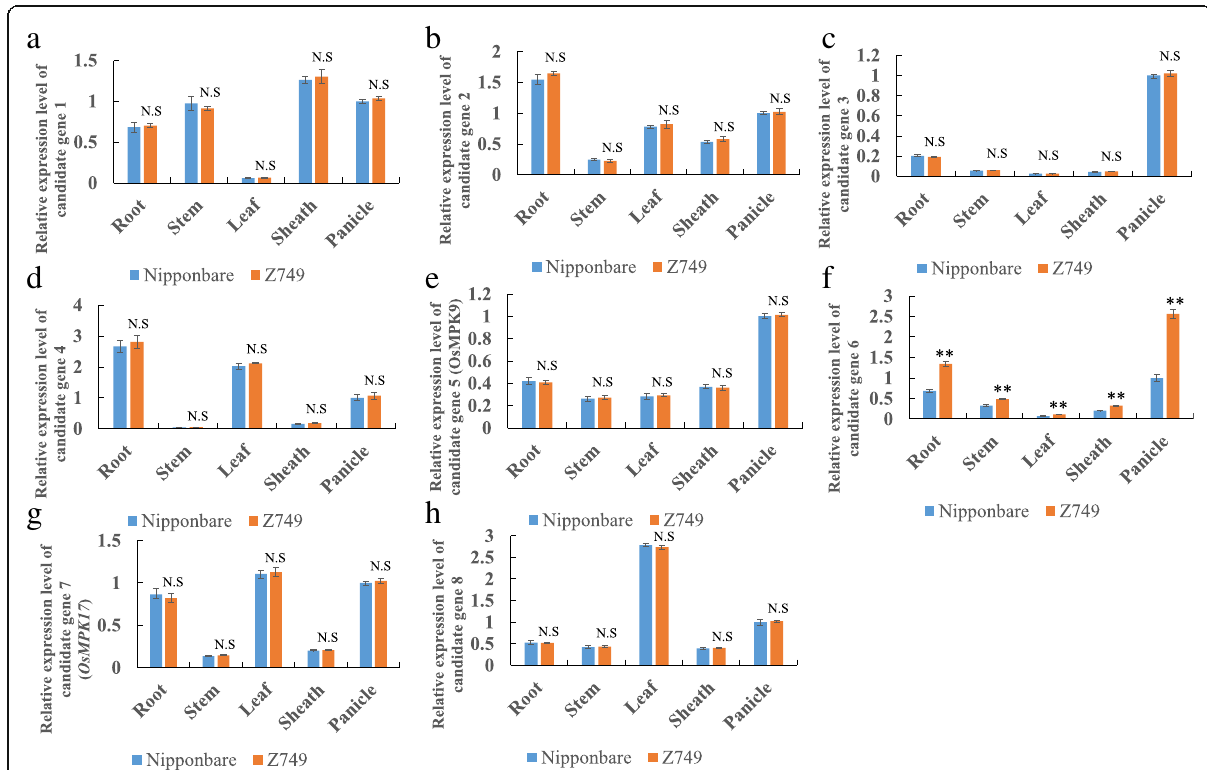
Fig. 6 Relative expression level of eight candidate genes for qSSD5 between Nipponbare and Z749. a - h Relative expression level of candidate genes 1 – 8 in root, stem, leaf, sheath and panicle between Nipponbare and